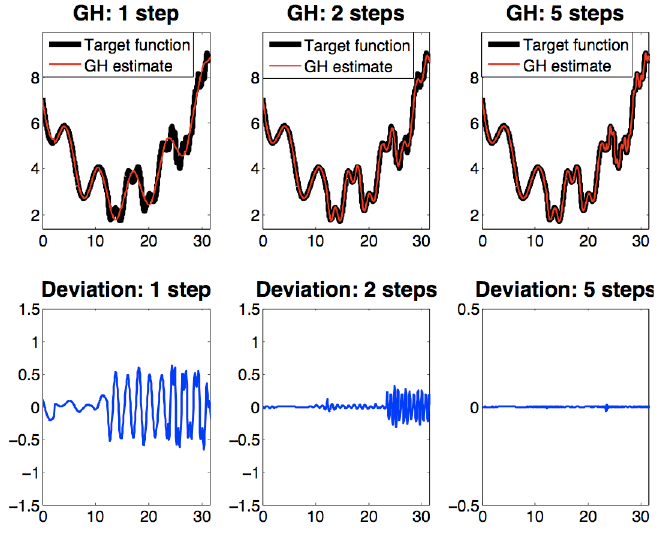
Figure 7. Geometric Harmonics on a multiscale target function (see the text). The sample dataset is formed by 2000 points evenly distributed in the interval [0 , 10 π ] . ( Top ) The Geometric Harmonics (GH) scheme is used as an interpolation procedure with ε ( Bottom ) The difference between the true function values and GH estimates. From left to right: Results corresponding to one, two and eight steps are reported.